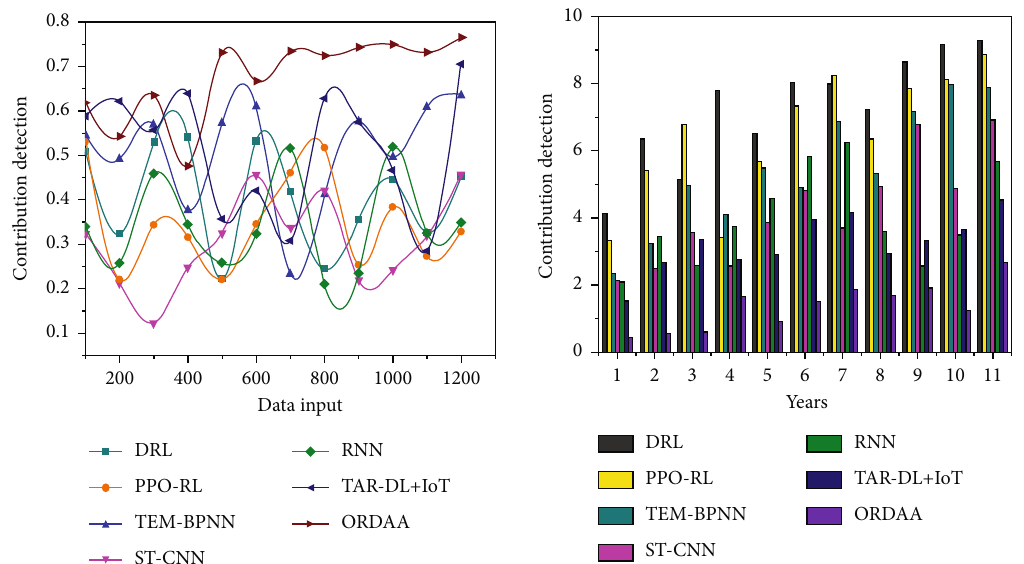
Figure 10: Contribution detection